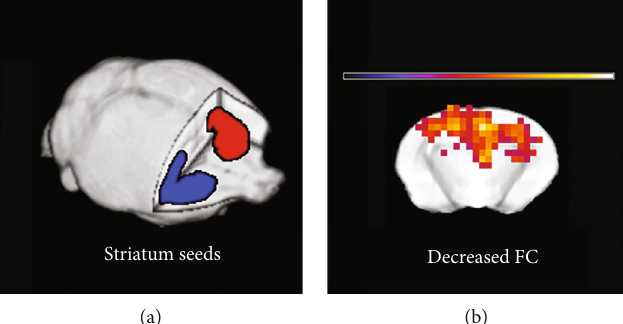
Figure 3: Abnormal resting-state functional connections between other regions of the whole brain with the bilateral striatum in both groups. Whole-brain RSFC map is created based on the blood oxygen level-dependent time series from spherical seed regions of the striatum. (a) Positions of striatum seeds. (b) Decreased FC between the striatums and other brain regions in Itpr2 -/-